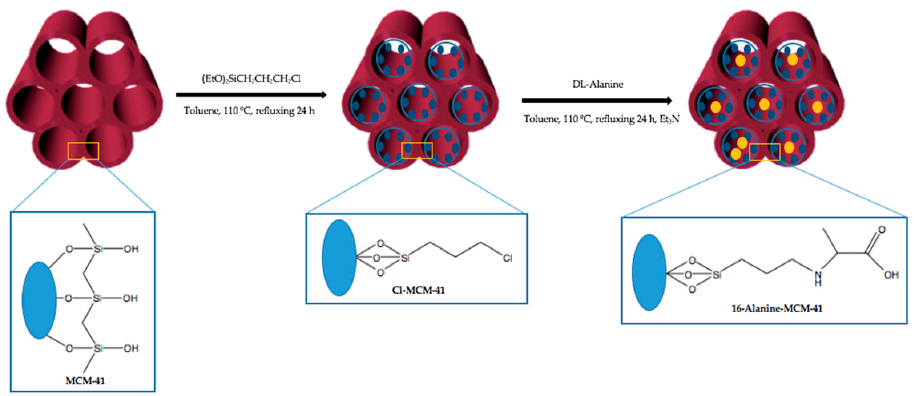
Figure 13 . DL-Alanine derivatized MCM-41.